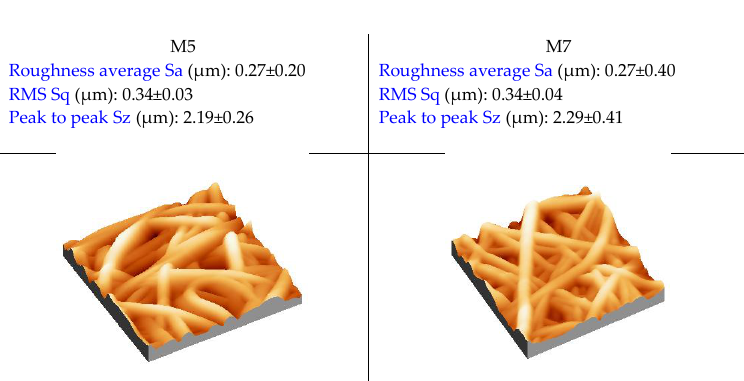
1 Figure 7. Atomic force microscopy (AFM) pictures of the PVDF ENMs and the values of roughness for M5 and M7 .